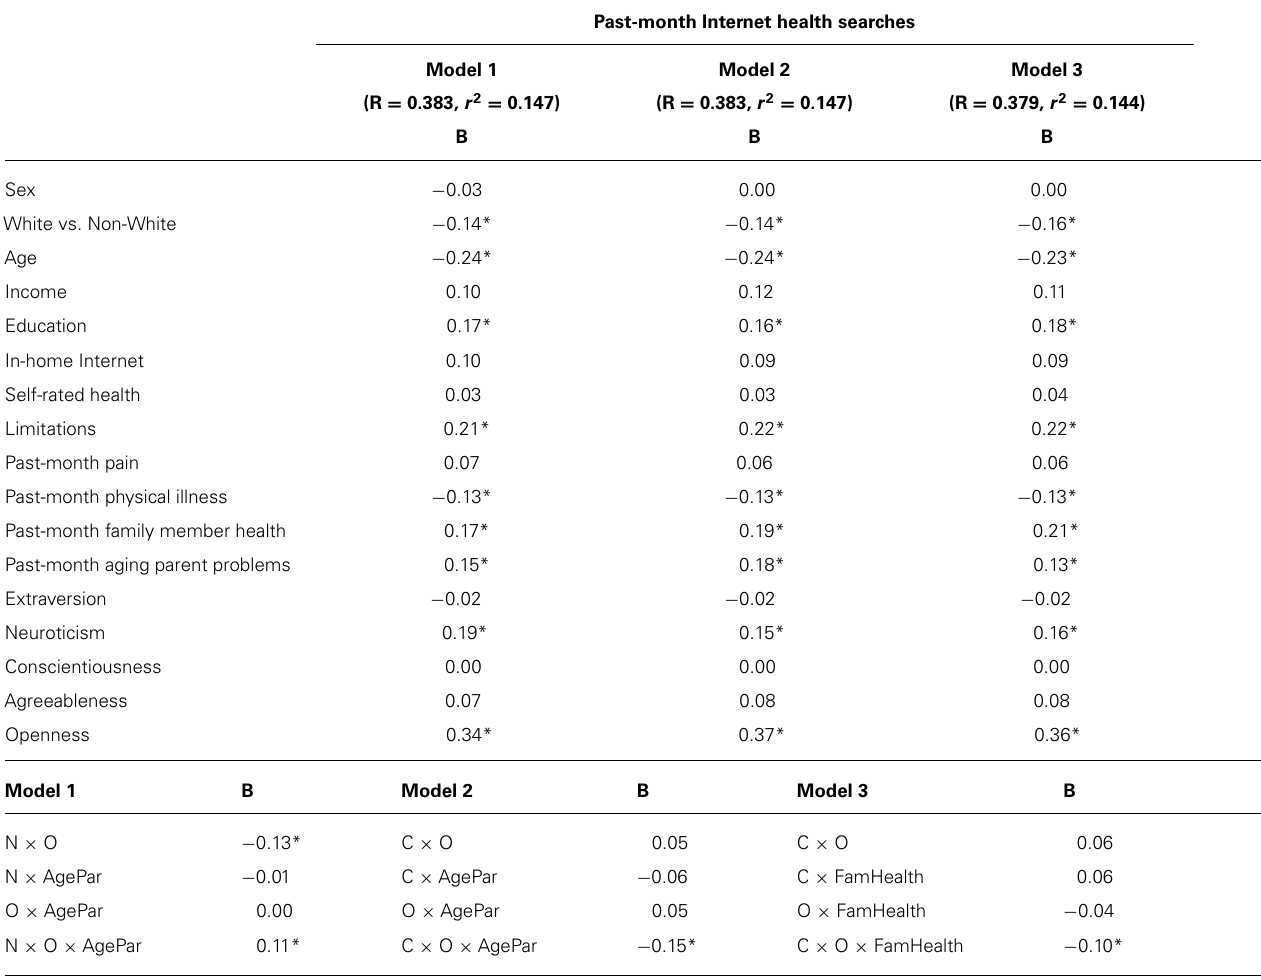
Table 3 |Additive and interactive effects of openness, neuroticism, conscientiousness, problems with aging parents, and health concerns for a family member on health-related Internet